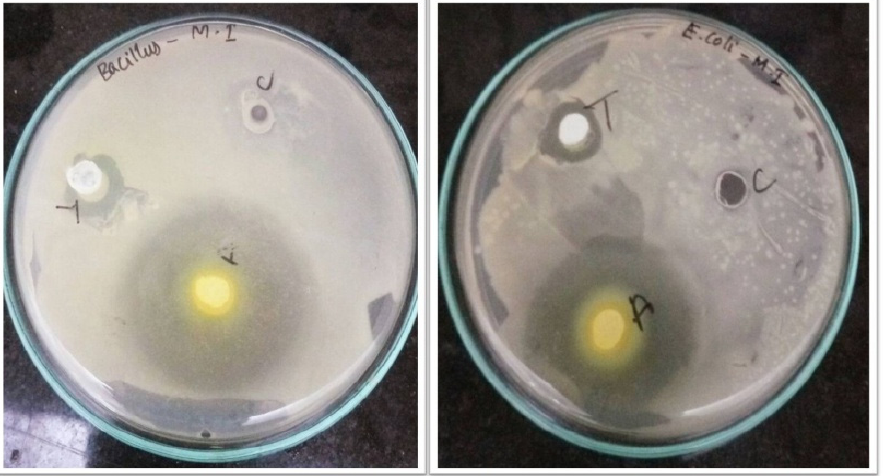
Figure 7. Synthesized ZnO NPs inhibit the growth of B. subtilis and E. coli . (A- M. indica seed-mediated ZnO NPs, T-Ampicillin, C-Zinc nitrate precursor solution).